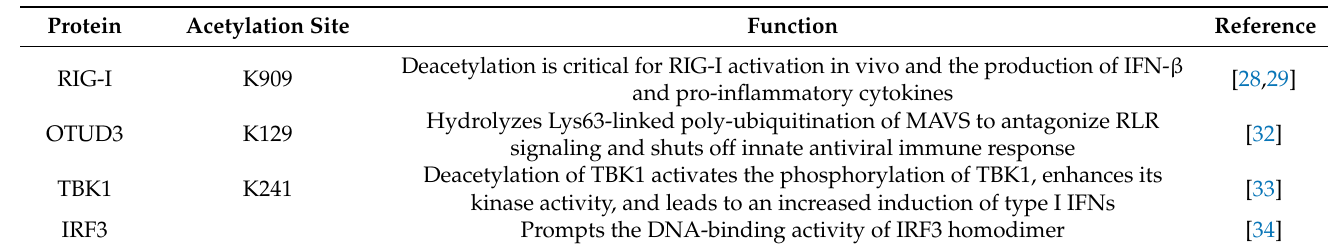
Table 2. Acetylation of host proteins during viral